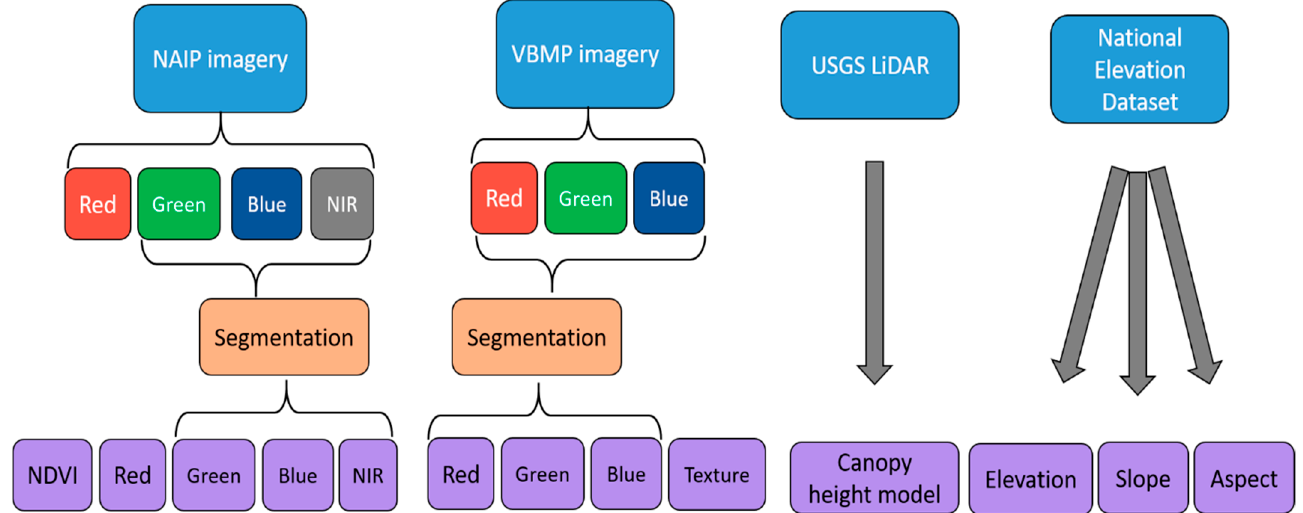
Figure 2. Flow diagram showing the steps from raw datasets (blue) to final predictor layers for the Random Forest Classification model (purple). For one county (Washington) the VBMP imagery portion of the diagram was omitted (see text).